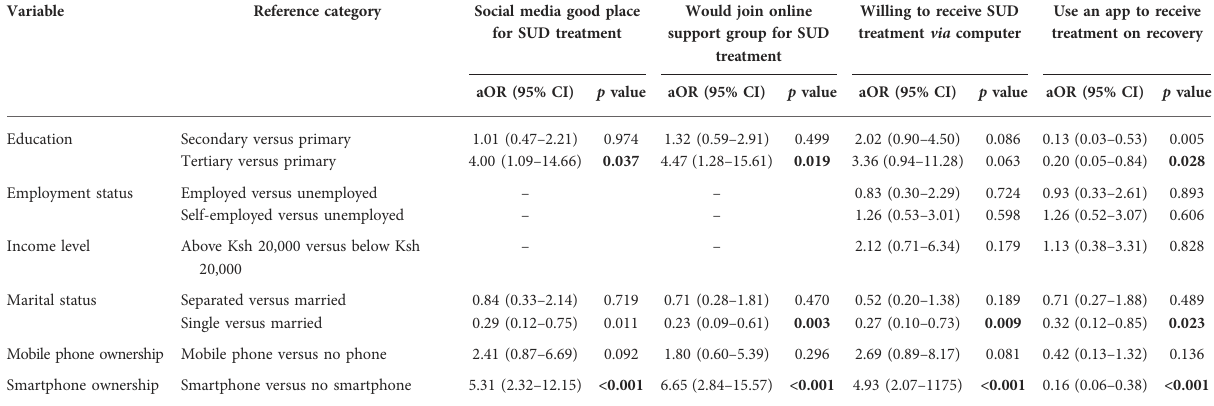
TABLE 8: Factors associated with acceptability of using digital technology in substance use disorder treatment on multivariate analysis.